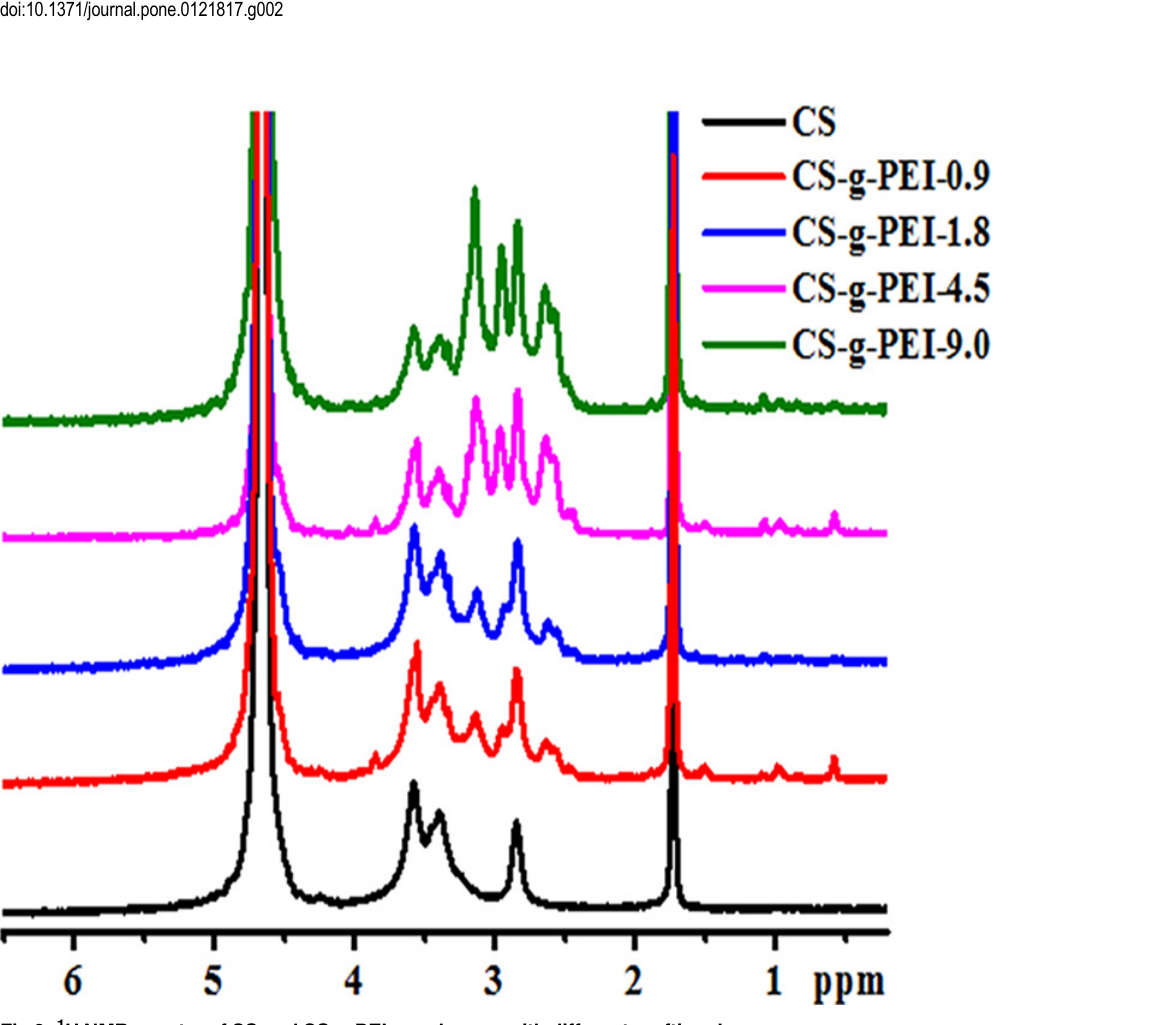
Fig 3. 1 H NMR spectra of CS and CS- g -PEI copolymers with different grafting degrees.